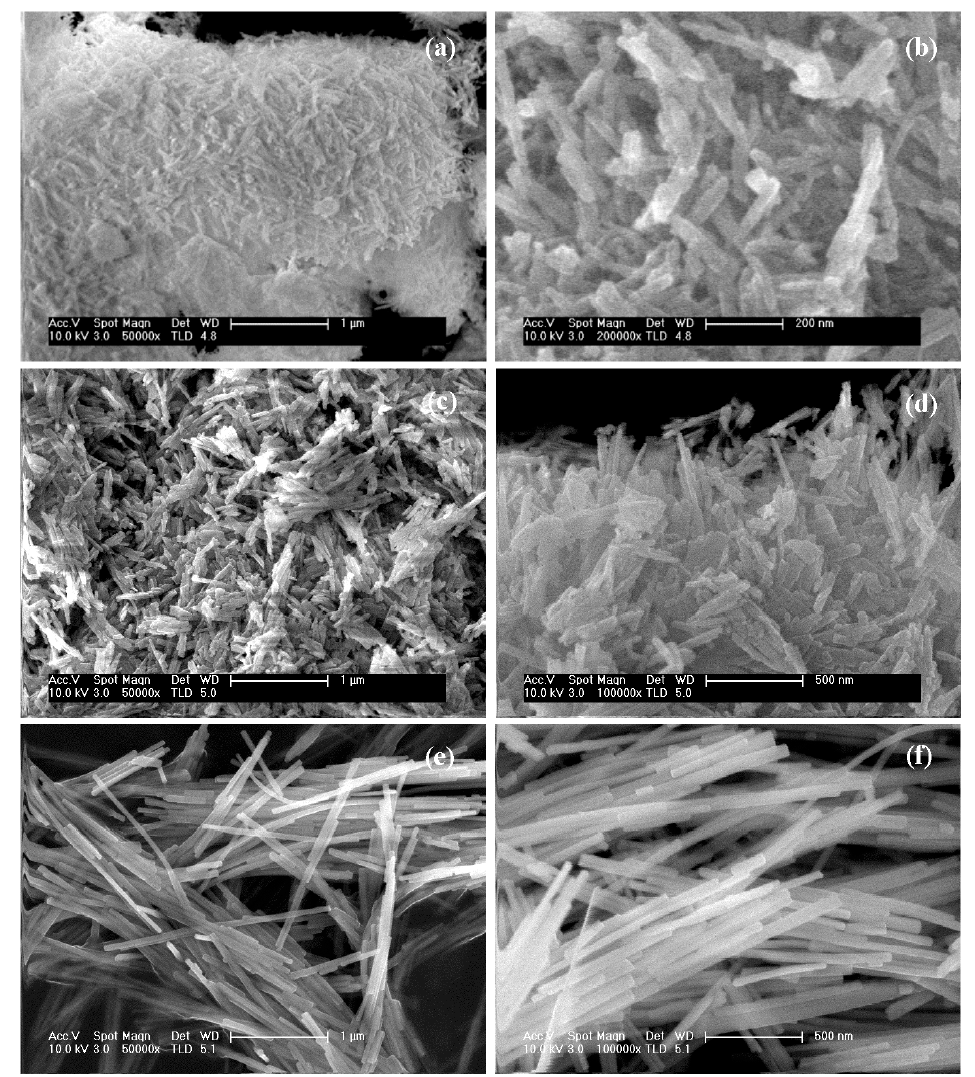
Figure 3. FE-SEM images of CdS samples prepared at different solvothermal temperature: ( a , b ) CdS-120; Figure ( c , d ) CdS-150 and ( e , f ) CdS-190.